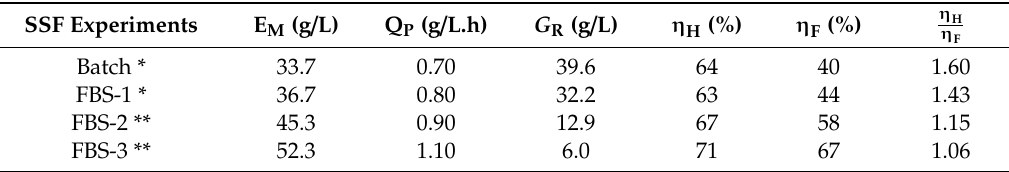
Table 8. Comparison of the batch and fed-batch SSF in the VBM reactor at 24% ( w / v ) final loading of pre-treated rice